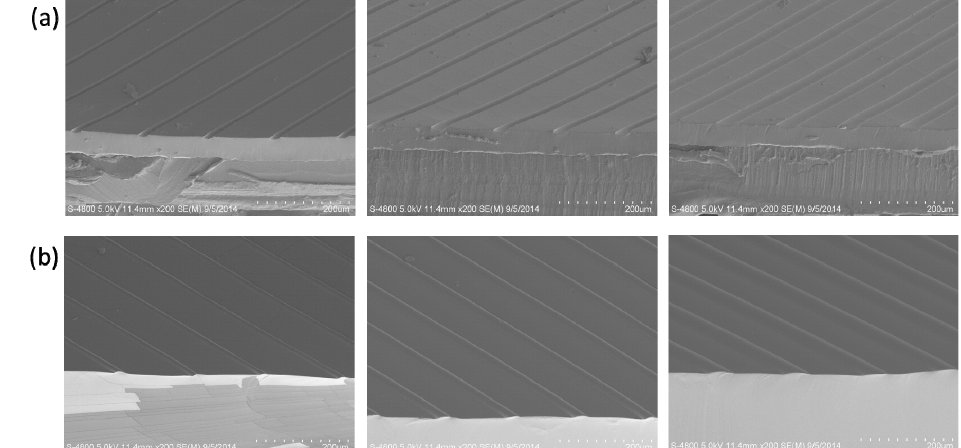
Figure 5. Cross-section morphologies of etched line templates and the microstructured surface with raised line based on the etched templates. ( a ) The etched templates with different inkjet printing layers (1, 3, 5 layers from left to right). ( b ) The replicated microstructures with different inkjet printing layers (1, 3, 5 layers from left to right).